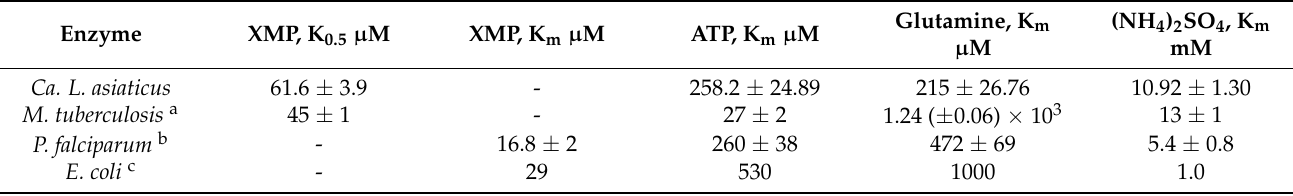
Figure 3. Apparent kinetic parameters for C Las GMPS. Specific activity as a function of the concentration. ( a ) XMP; ( b ) ATP; ( c ) glutamine; ( d ) NH 4+ . Table 4. Kinetic parameters of different species GMPSs.